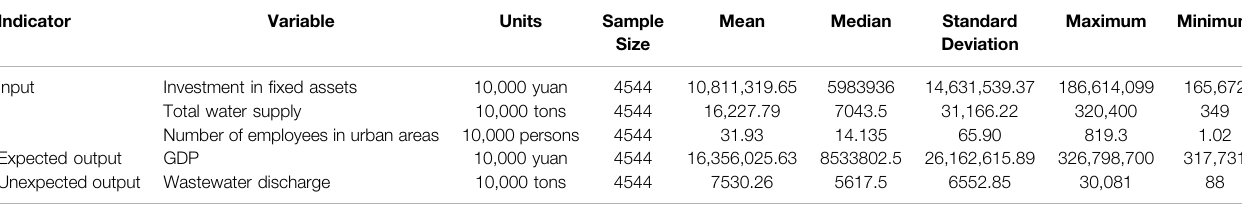
TABLE 1 | Descriptive statistics of the indicators of